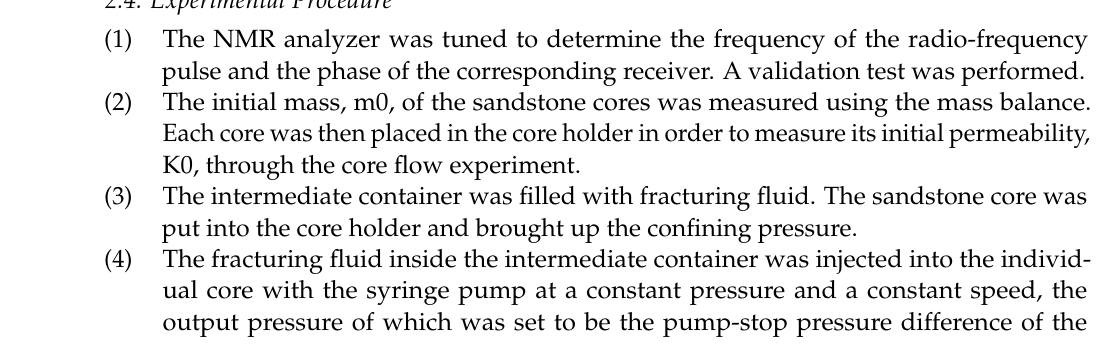
Table 2. Statistics of the imbibition pressure and time in different formation layers of the Linxing tight gas reservoir.